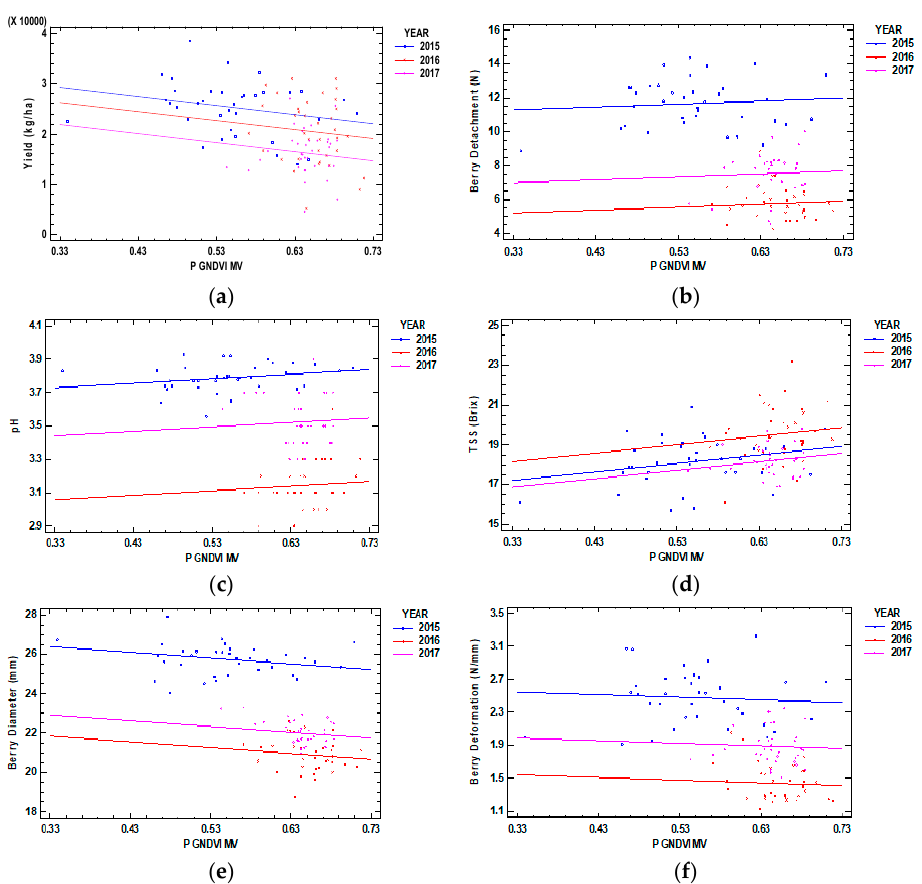
Figure 5. Scatterplots of P GNDVI MV with ( a ) yield, ( b ) berry detachment, ( c ) pH, ( d ) total soluble solids, ( e ) berry diameter, and ( f ) berry deformation.